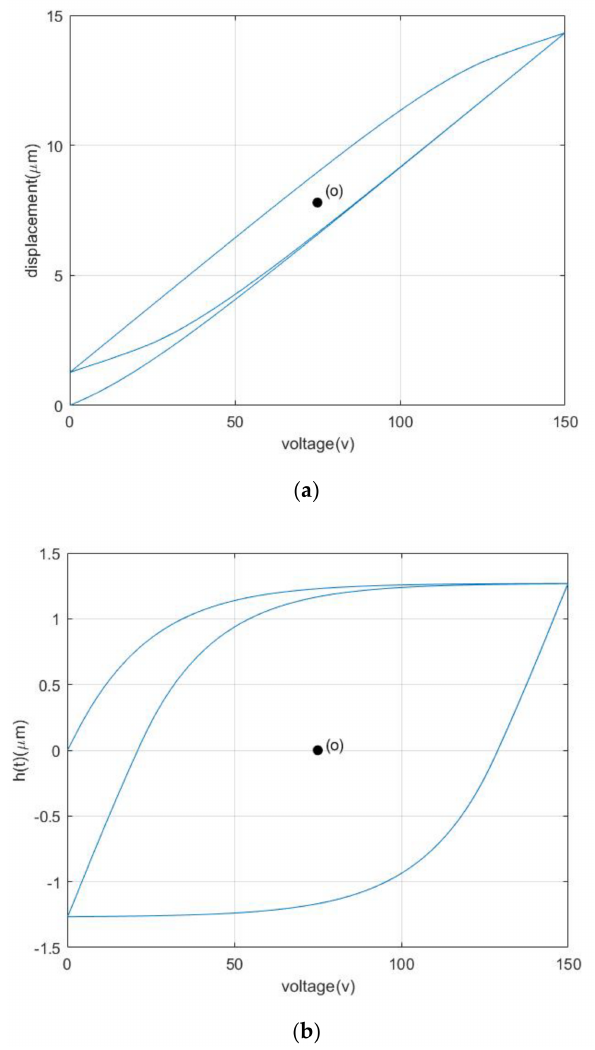
Figure 3. Output displacement and nonlinear components of Bouc − Wen model. ( a ) Output displace- ment of Bouc − Wen model. ( b ) Nonlinear component of Bouc − Wen